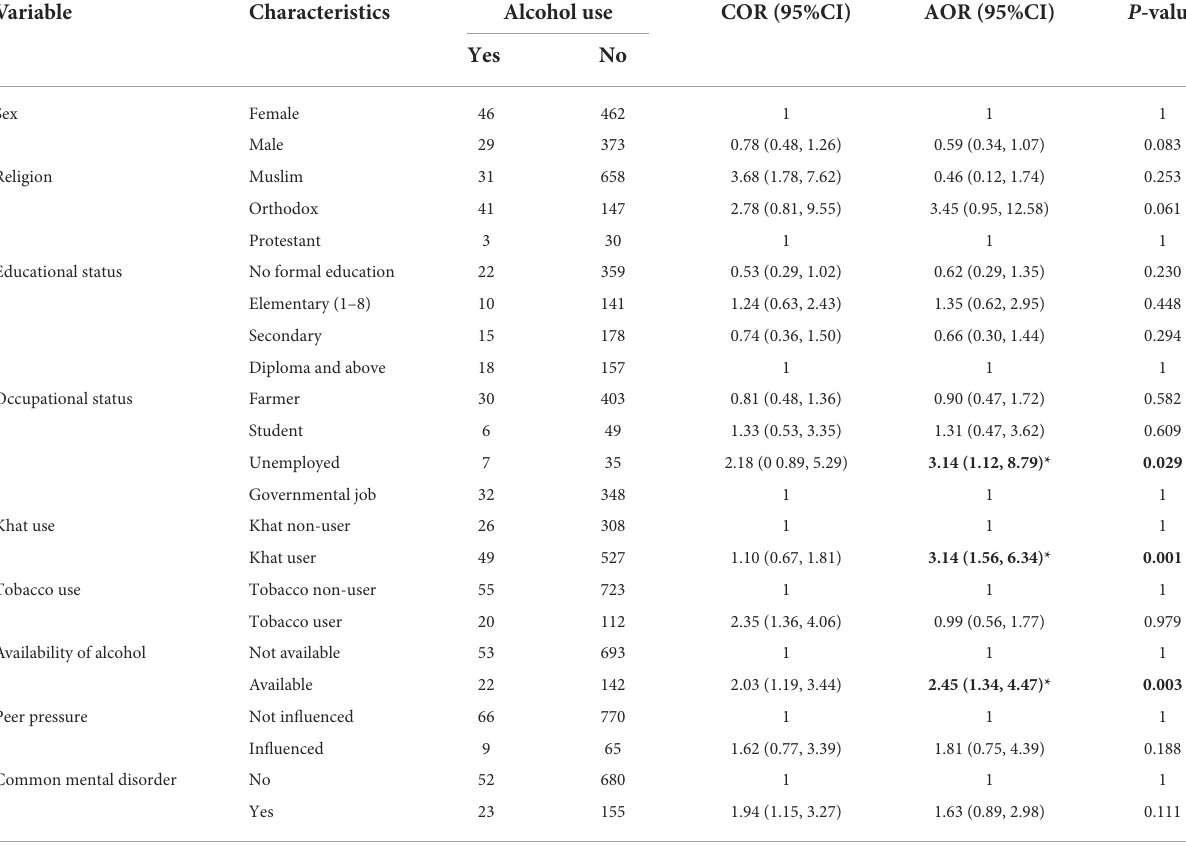
TABLE 2 Factors associated with alcohol use among adult residents of Harari regional state, eastern Ethiopia ( N =